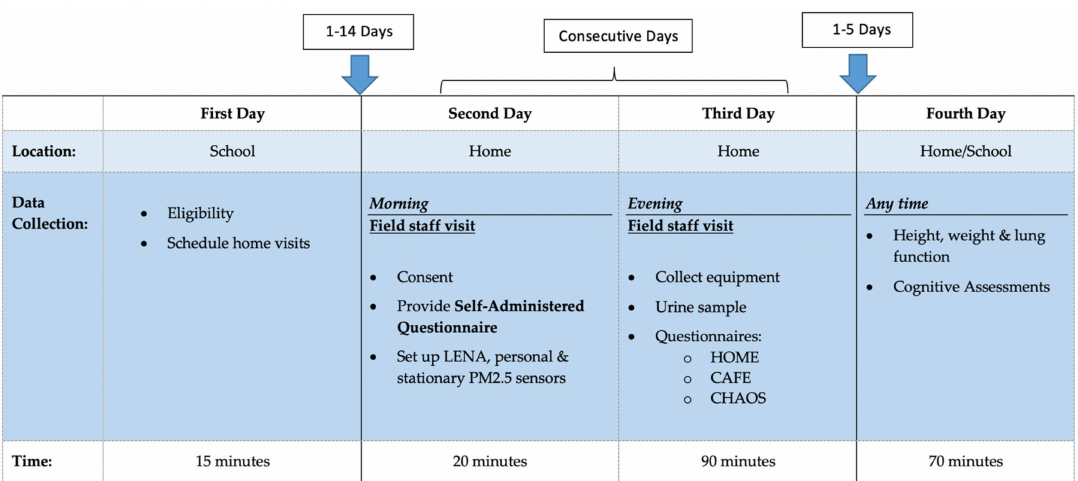
Figure 2. Description of the data collected for the feasibility study, organized by day of collection, location, and estimated time spent. Intervals between study days are labeled above the table. LENA: Language Environment Analysis System; HOME: Home Observation for Measurement of the Environment; CAFE: Comprehensive Assessment of Family Media Exposure; CHAOS: Confusion, Hubbub, and Order